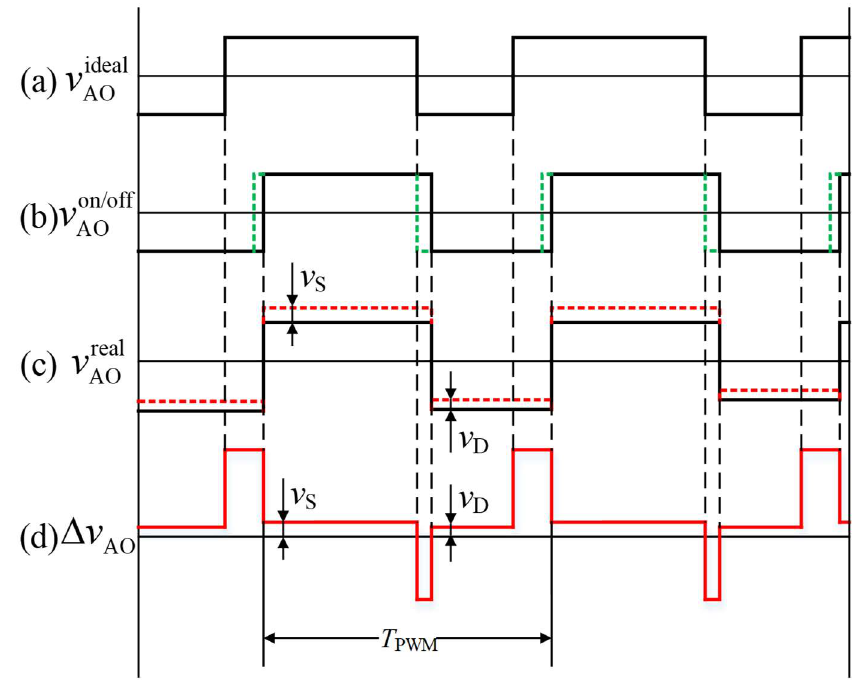
Figure 5. Inverter output voltage waveforms. ( a ) Ideal inverter; ( b ) Actual inverter considering dead time; ( c ) Actual inverter considering dead time and on-voltage; ( d ) Error voltage waveform (ideal output—actual output, a – c ).